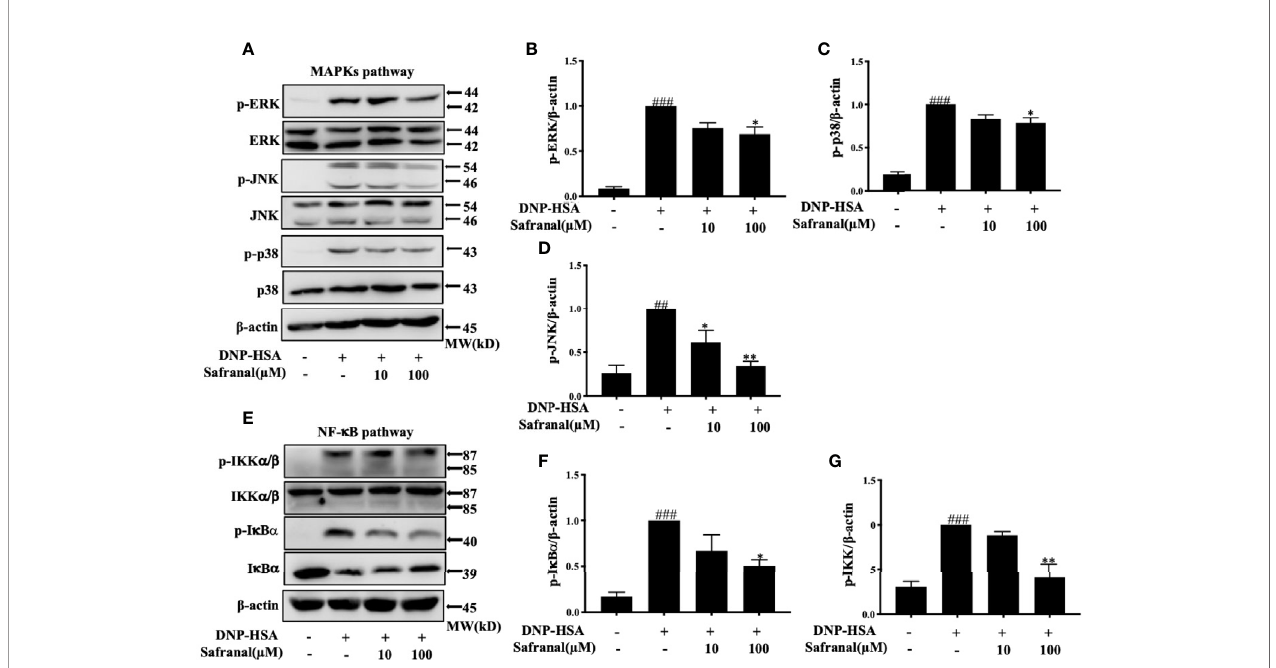
FIGURE 7 | Safranal inhibited the MAPKs and NF- k B signaling pathways. Cells were pretreated with Safranal for 1 h prior to DNP-HSA treatment. The levels of phosphorylation of proteins in MAPKs pathways ERK, JNK and p38 (A – D) and NF- k B pathway IKK and I k B a (E – G) were measured by western blot and normalized to b -actin. The data shown are representative of three independent experiments and indicate the means ± S.E.M. ## p < 0.01, ### p <0.001 compared to nontreated group, * p <0.05, ** p <0.01compared to